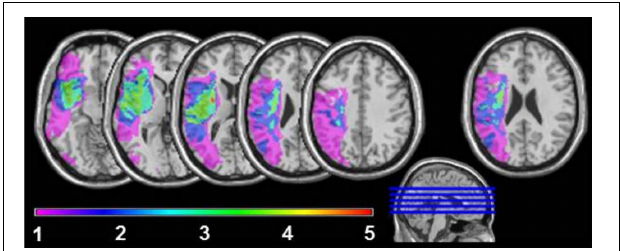
FIGURE 1 | Lesion sites overlapping in 1, 2, 3, 4, or 5 of the agrammatic speakers. For the very right axial slice, first a lesion overlay of 11 non-agrammatic aphasic speakers was plotted. Next the brain areas, where at least 6 lesions overlapped, were subtracted from the overlay plot of lesion sites in the five agrammatic speakers to adjust for areas with higher anatomical